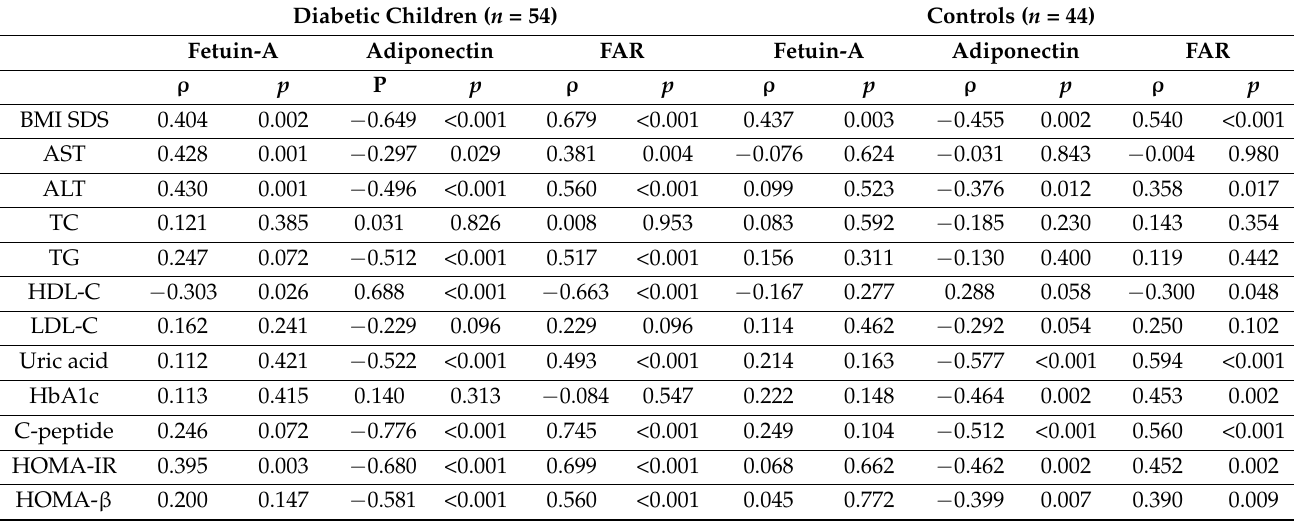
Table 4. Spearman’s rank correlation of plasma fetuin-A, adiponectin, and the fetuin-A-to-adiponectin ratio with the clinical and laboratory characteristics of diabetic children and